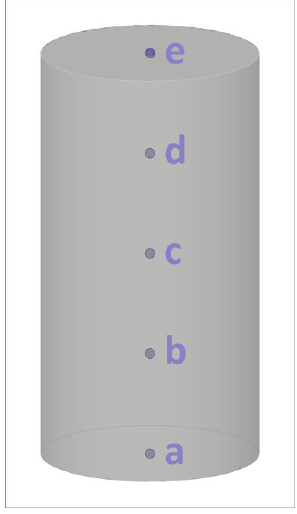
Fig. 2. Deformed mesh (exaggerated scale, deformations  1000)